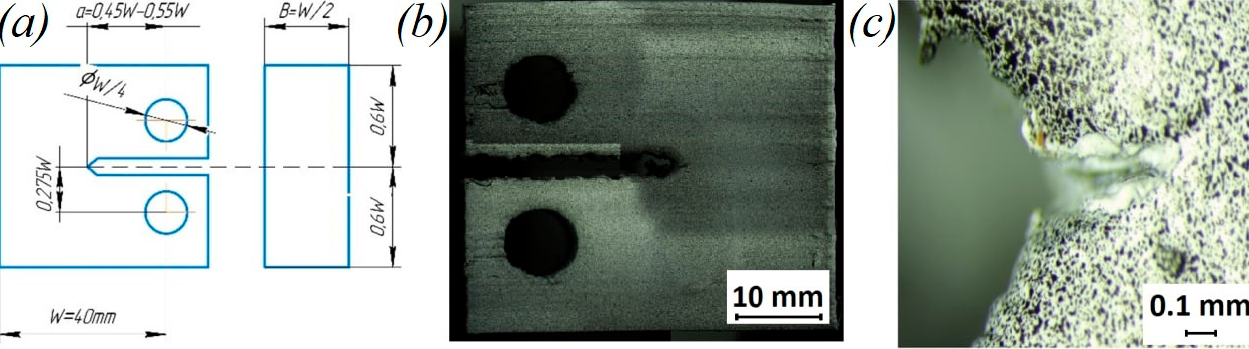
Figure 4. ( a ) Geometry of CT sample; ( b ) PEEK CT sample with speckles; and ( c ) enlarged view of crack is sharp edge area of sample.